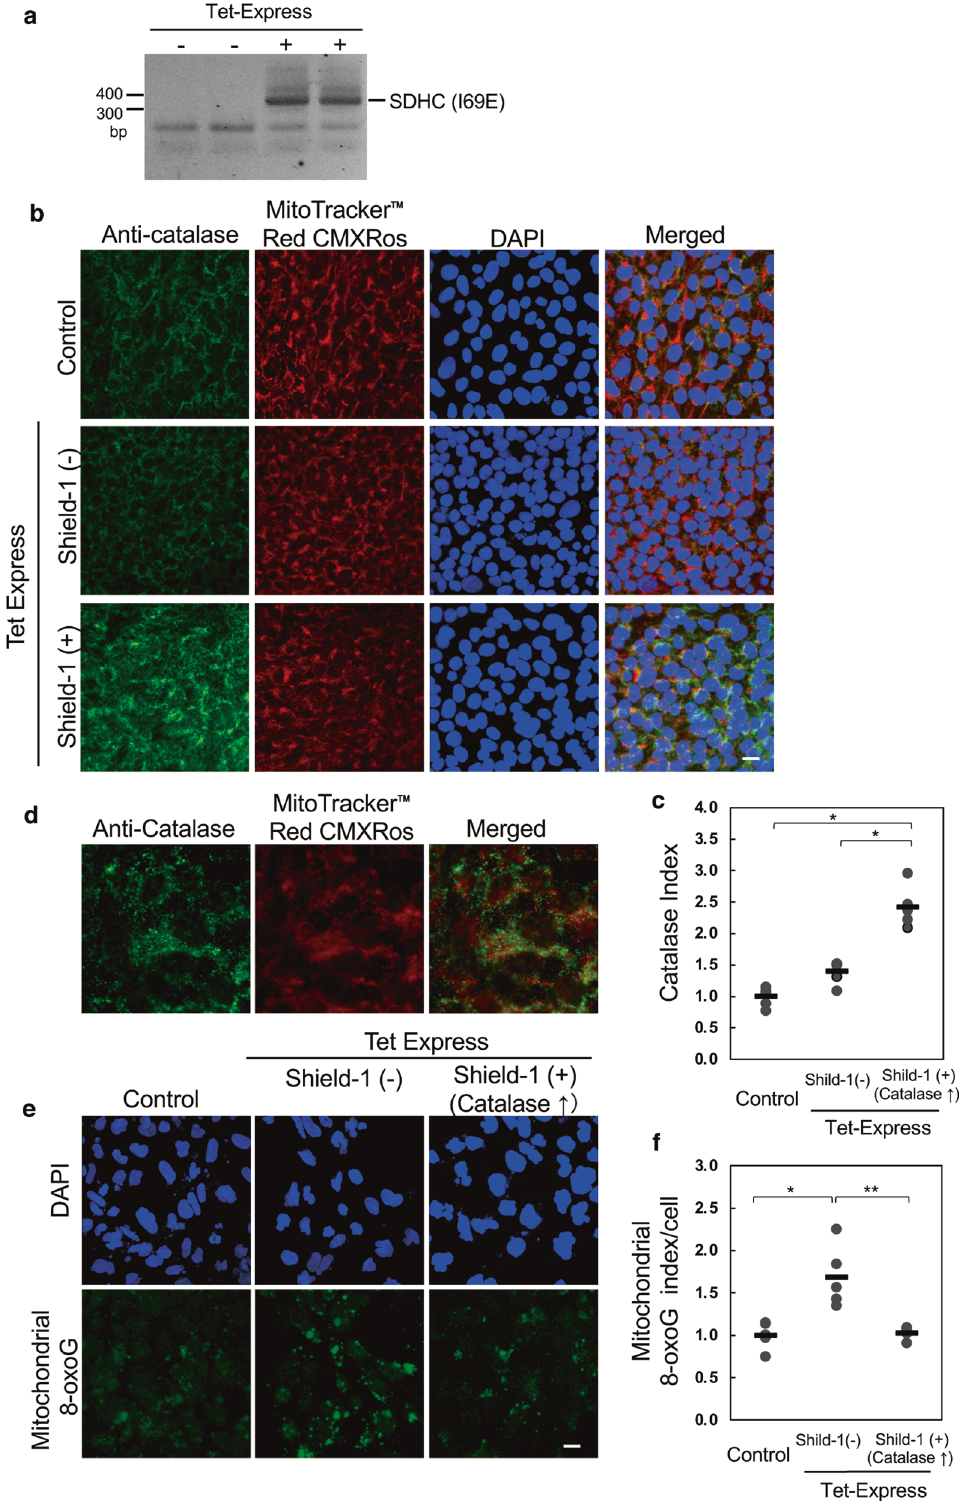
treatment (control, upper panels). In contrast, cells treated with both Tet-Express and Shield-1 showed a marked increase of the signal intensity (lower panels, Shield-1 [ + ]). The dot plot of the relative catalase index revealed catalase overexpression in ChiPSC12-CAT cells by Shield-1 protein treatment (Fig. 3c). As Cell Death Discovery (2022)